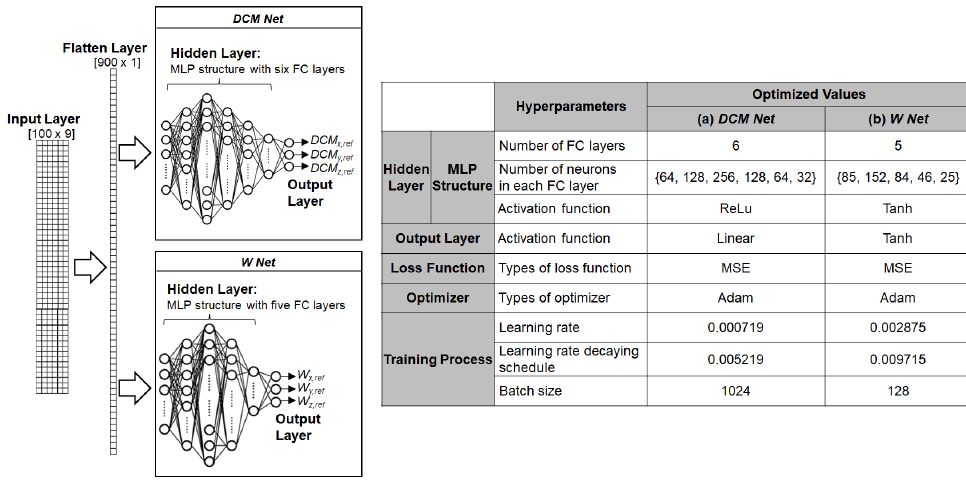
Figure 10. Structures of DCM Net and W Net for the behavior cloning model used in the dynamic simulator: hyperparameters for ( a ) DCM Net and ( b ) W Net.